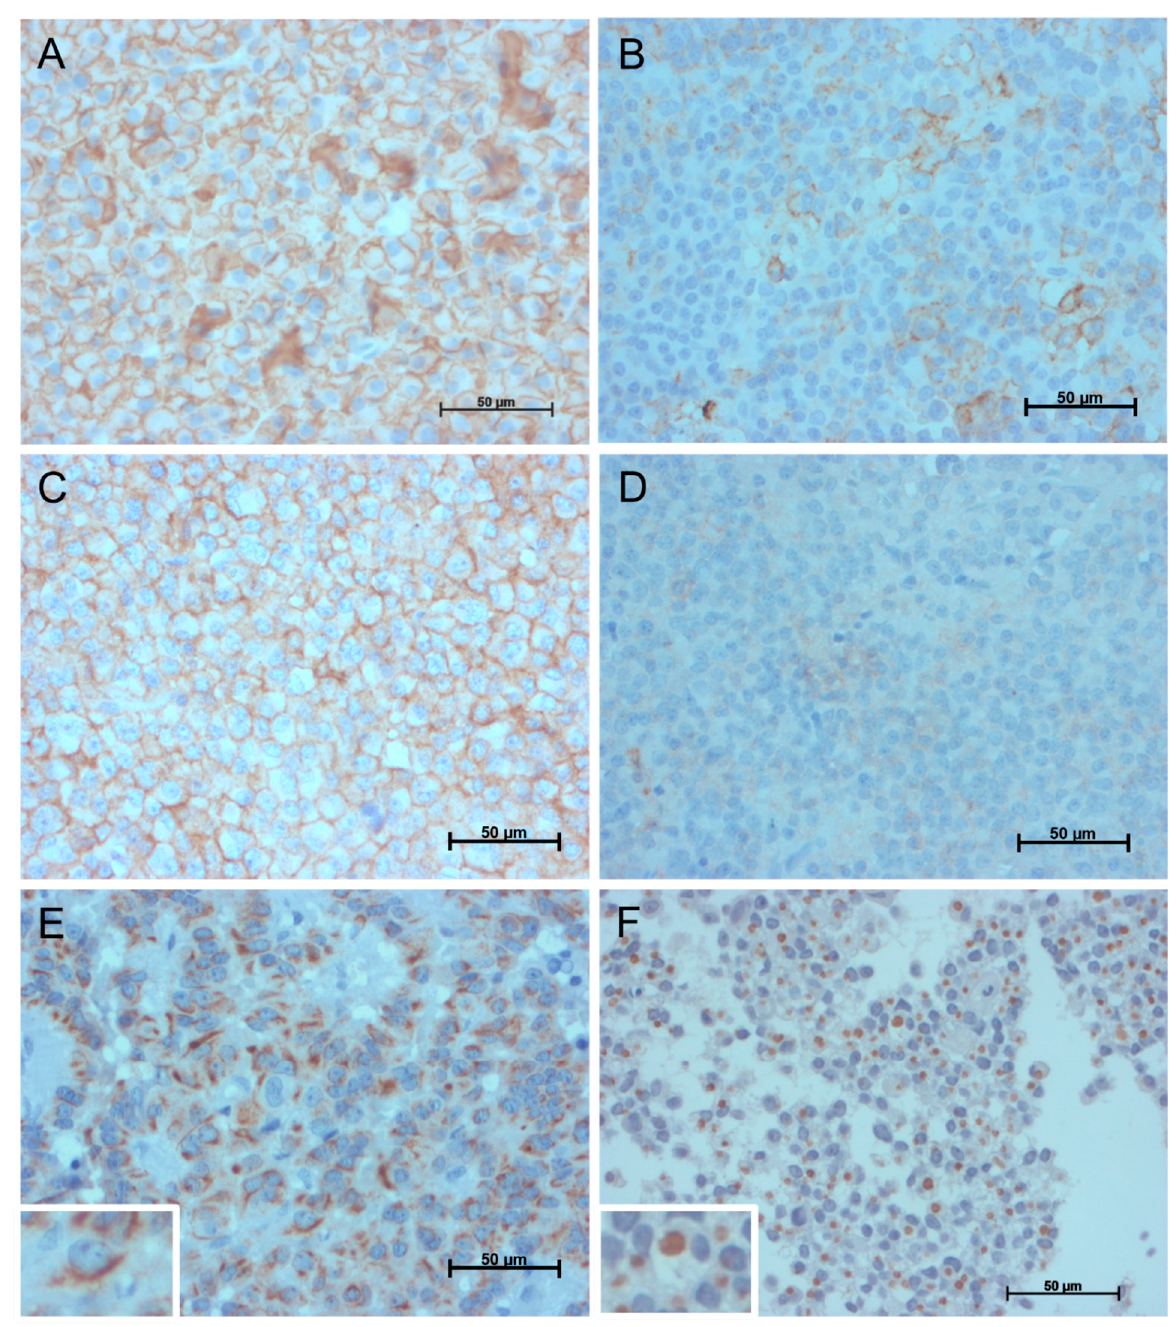
Figure 1. Representative images of immunohistochemical expression patterns of somatostatin receptors subtype 2 and 5 and cytokeratin. ( A ) micrograph showing membrane SST2 immunostaining in 100% of cells with high intensity (IRS score 12–high); ( B ) SST2 immunostaining in approximately 20% of cells with moderate intentisty (IRS 4–low); ( C ) SST5 immunostaining in 100% of cells with high intensity (IRS score 12–high); ( D ) SST5 immunostaining in less than 10% of cells with low intensity (IRS 1–low); ( E ) densely granulated tumor—inset shows a magnified view of the perinuclear staining; and ( F ) sparsely granulated tumor—inset shows a magnified view of the dot-like staining.